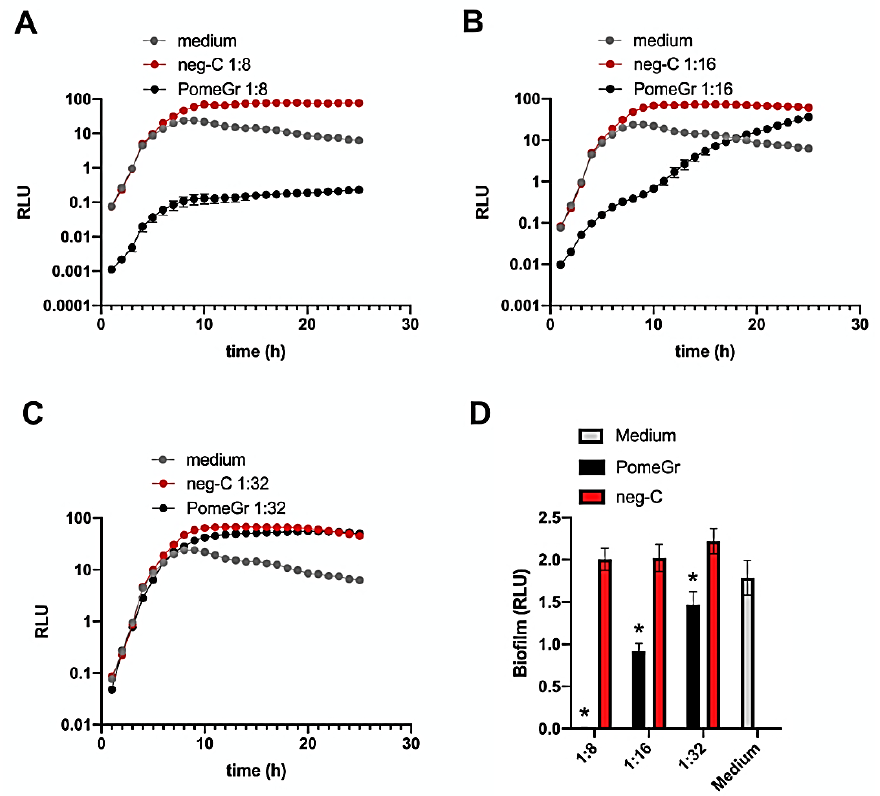
Figure 1. The PomeGr effects on P. aeruginosa growth and biofilm formation. P. aeruginosa (10 6 /mL, 100 µ L/well) was exposed for 24 h to PomeGr or neg-C (100 µ L/well) at dilutions of 1:8, 1:16 and 1:32. By BLI assay, the total microbial load was kinetically measured every hour (Panel A : 1:8 dilution; Panel B : 1:16 dilution; Panel C : 1:32 dilution). The samples were then washed and the biofilm formation was quantified by an additional bioluminescence reading (Panel D ). The results shown are the mean ( ± SEM) of the RLU from 9–12 replicates of three independent experiments. The asterisk indicates p ≤ 0.001 (PomeGr vs.